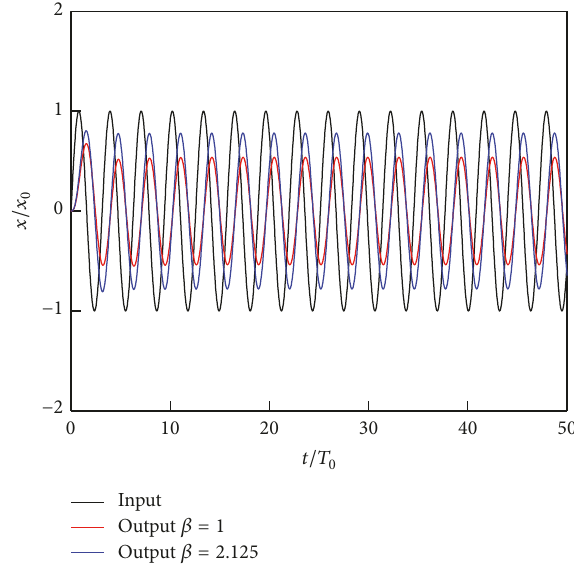
Figure 40: Response in the time domain ( 𝛼 = 4, 𝛽 = 1, 2.125, 𝜔/𝜔 = 2 0